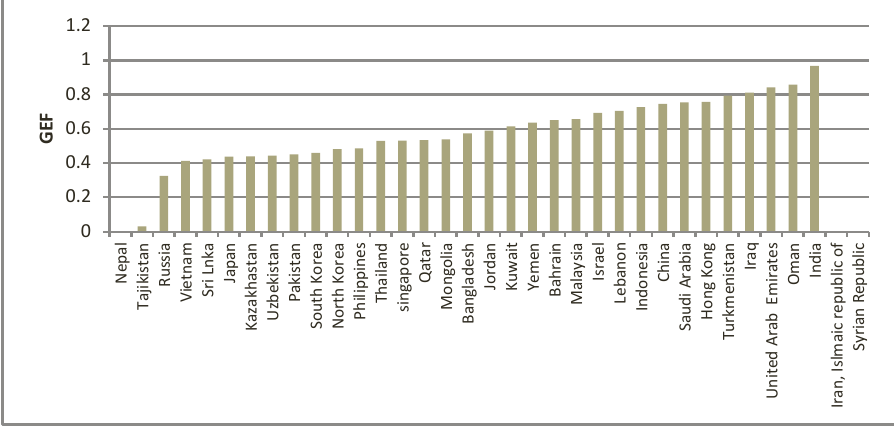
FIGURE 2: Average GEFs of Asian countries (2008) Source: